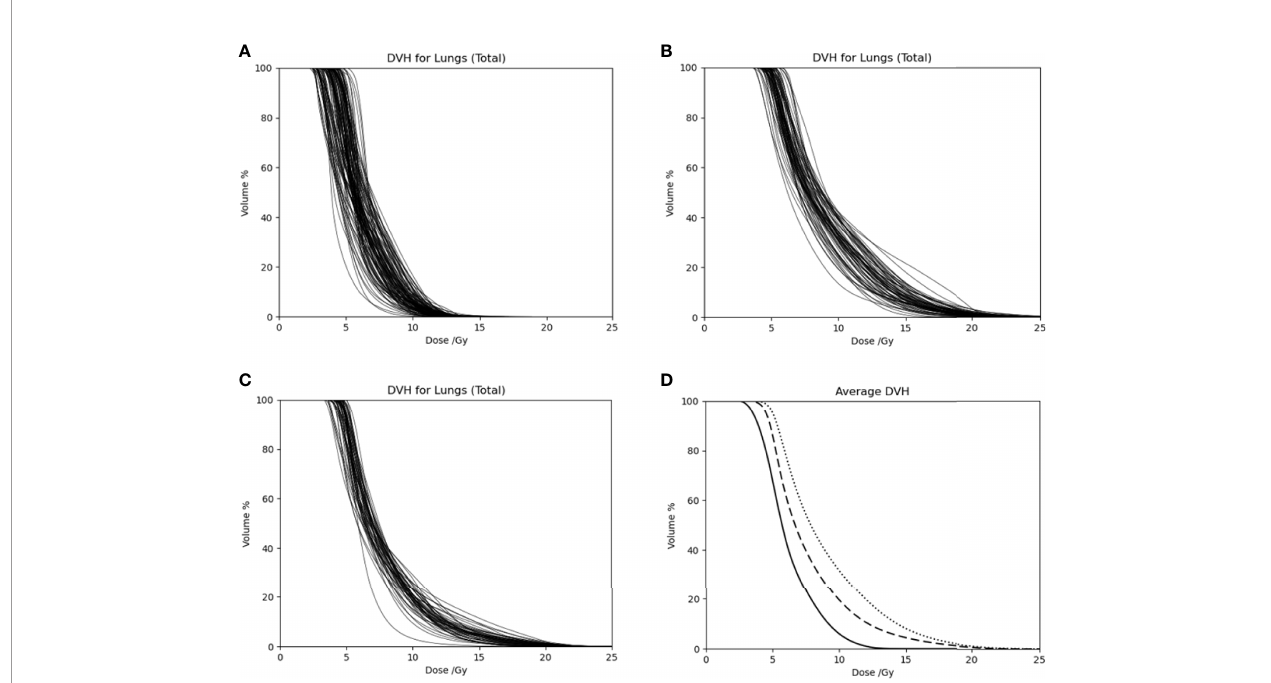
FIGURE 3 | Dose volume histograms of the total lung for (A) patients in the 12-Gy cohort, (B) patients in the 20-Gy cohort before the updated mean lung dose constraint was used, and (C) patients in the 20-Gy cohort after the updated mean lung dose constraint was used. (D) Average DVH curves for patients in the 12-Gy cohort (solid curve), patients in the 20-Gy cohort before the updated mean lung dose constraint was used (dotted curve), and patients in the 20-Gy cohort after the mean lung dose constraint was used (dashed curve).